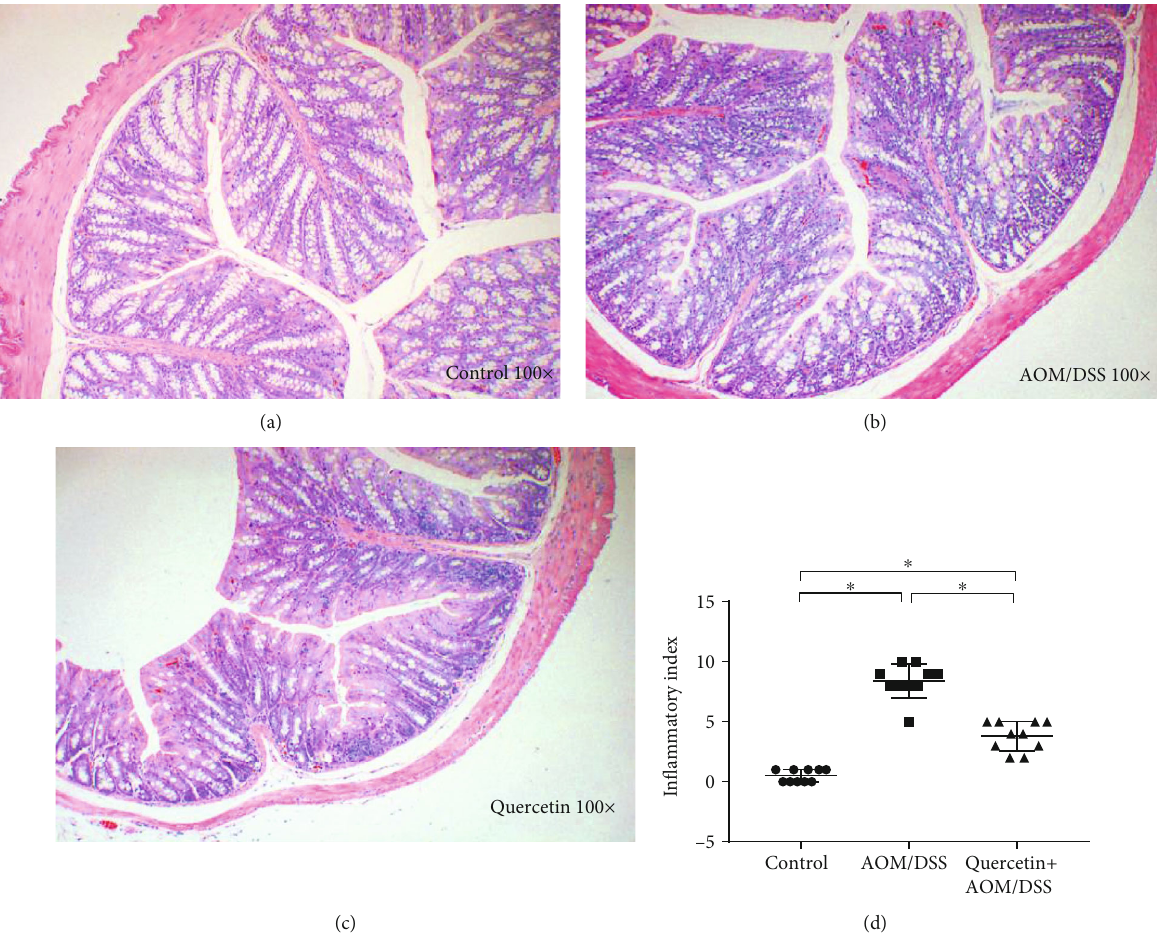
Figure 4: Quercetin reduces in fl ammation in AOM/DSS-treated mice. (a) H&E staining fi gure in the control group. (b) H&E staining fi gure in the AOM/DSS group. (c) H&E staining fi gure in the quercetin+AOM/DSS group. (d) In fl ammatory index of the three groups. ∗ P < 0 : 05 , Student ’ s t -test, data representative of three independent experiments presented as mean values ± SD ( n = 10